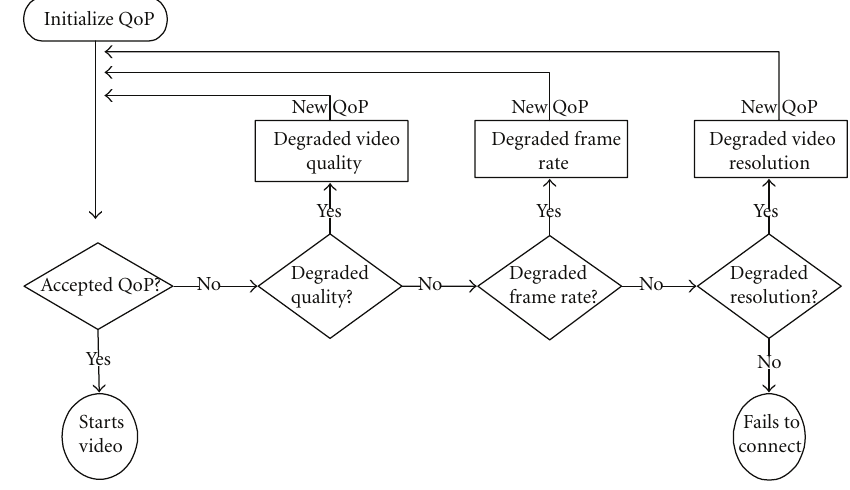
Figure 3: QoP regeneration